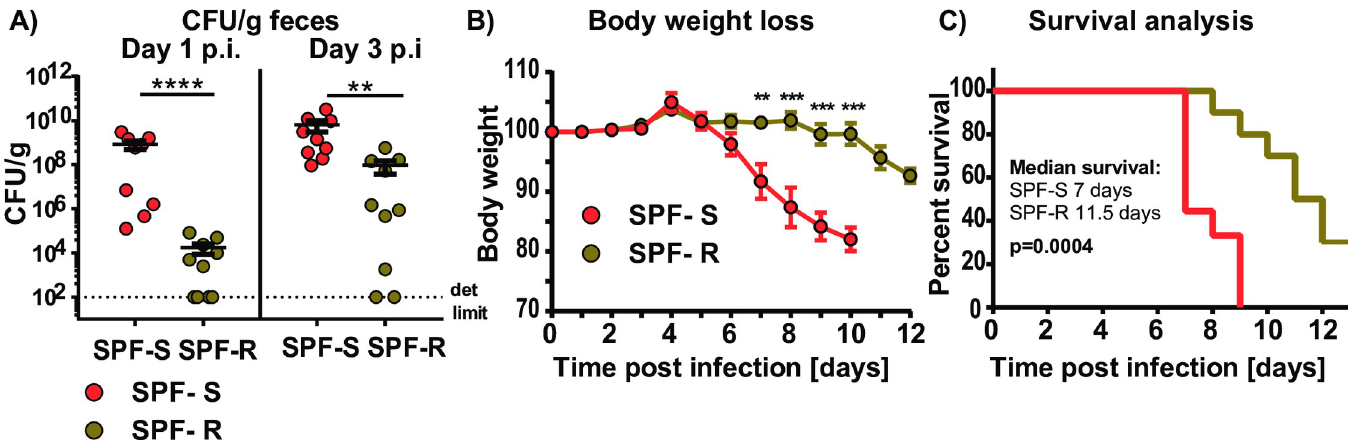
Fig 2. Variations in microbiota composition are correlated with lethal outcome of infections with a Shiga toxin-expressing C . rodentium strains. (A-C) SPF-S and SPF-R mice were infected orally with 10 8 CFU C . rodentium DBS 770 and fecal colonization, body weight loss and survival were determined. Dashed lines indicate the limit of detection. Results represent two independent experiments with n = 4–5 mice/group as mean ± SEM. P values indicated represent a nonparametric Kruskal-Wallis test � p < 0.05, �� p < 0.01, ��� p < 0.001, ���� p < 0.0001.